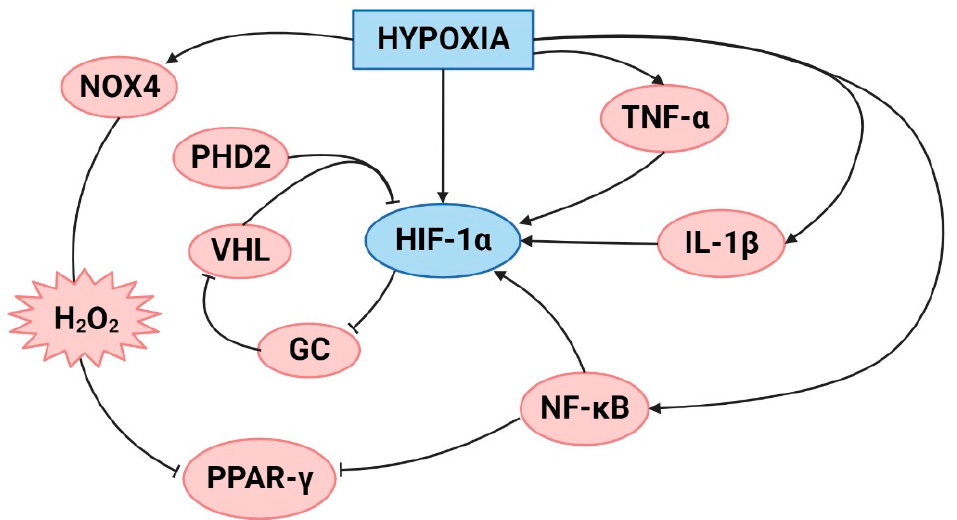
Figure 1. Proposed summary of the crosstalk between hypoxia and inflammation. Created with Bi- oRender.com.